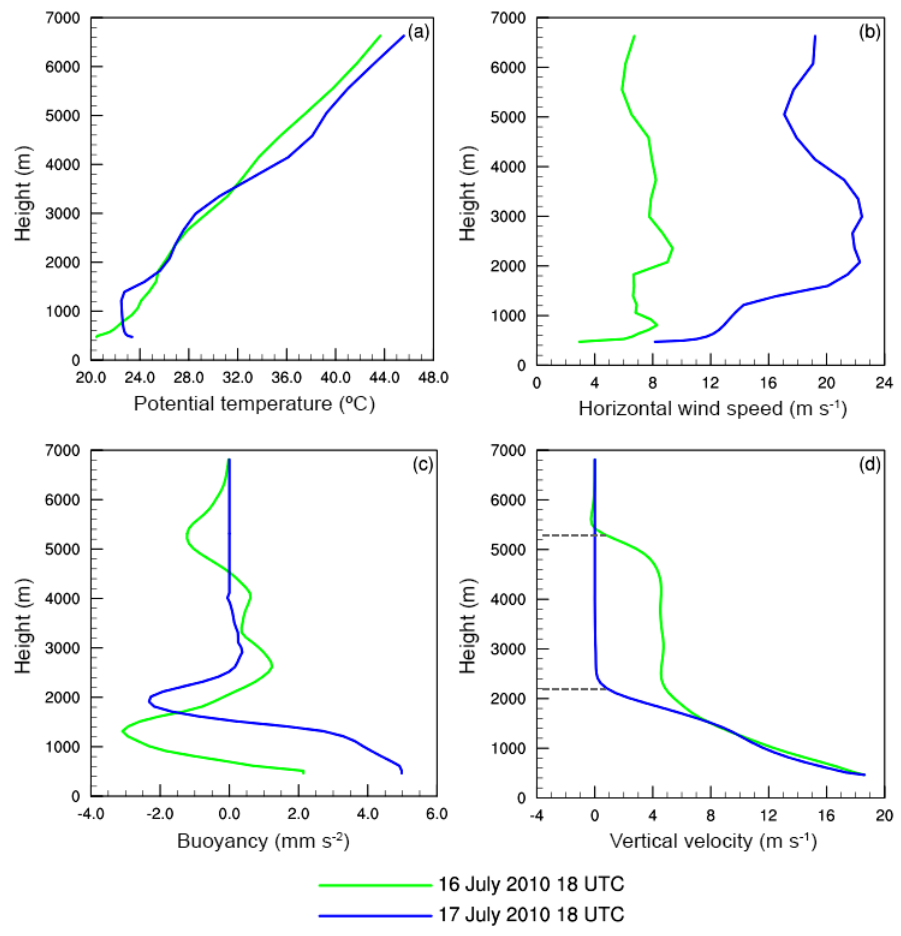
Figure 1. The potential temperature (a) and horizontal wind speed (b) of the environment and the calculated buoyancy (c) , and vertical velocity (d) for an imaginary fire in central Saskatchewan, Canada, for 16 July 2010 at 18:00UTC and 17 July 2010 at